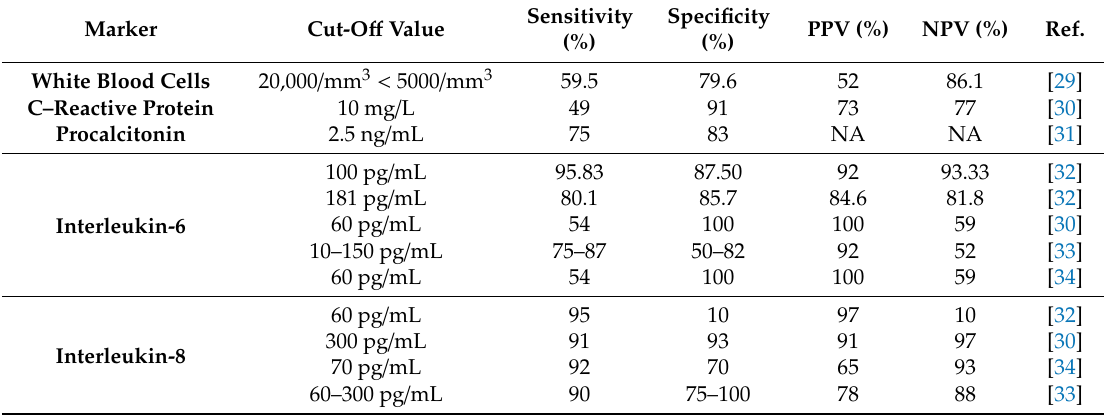
Figure 2. Schematic representation of common and developing biomarkers for neonatal early-onset sepsis. Table 2. Currently used biomarkers for sepsis diagnosis in neonates .